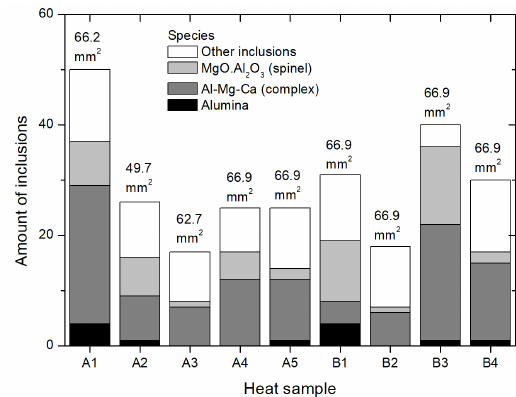
Figure 9. Amount and species of inclusions detected in the tundish. Sample